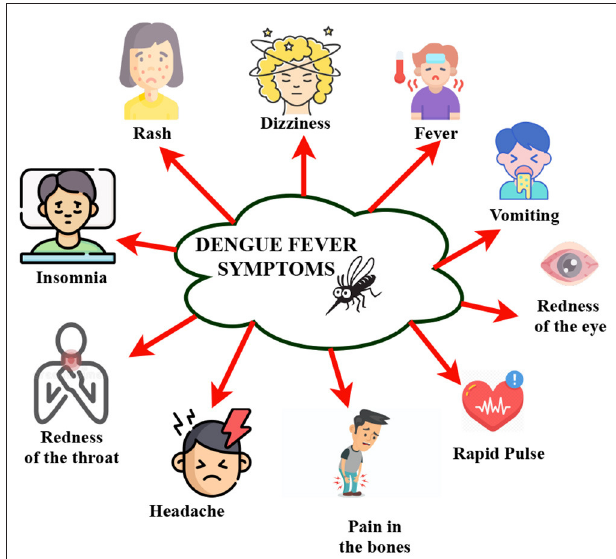
FIGURE 3 | Symptoms of dengue.